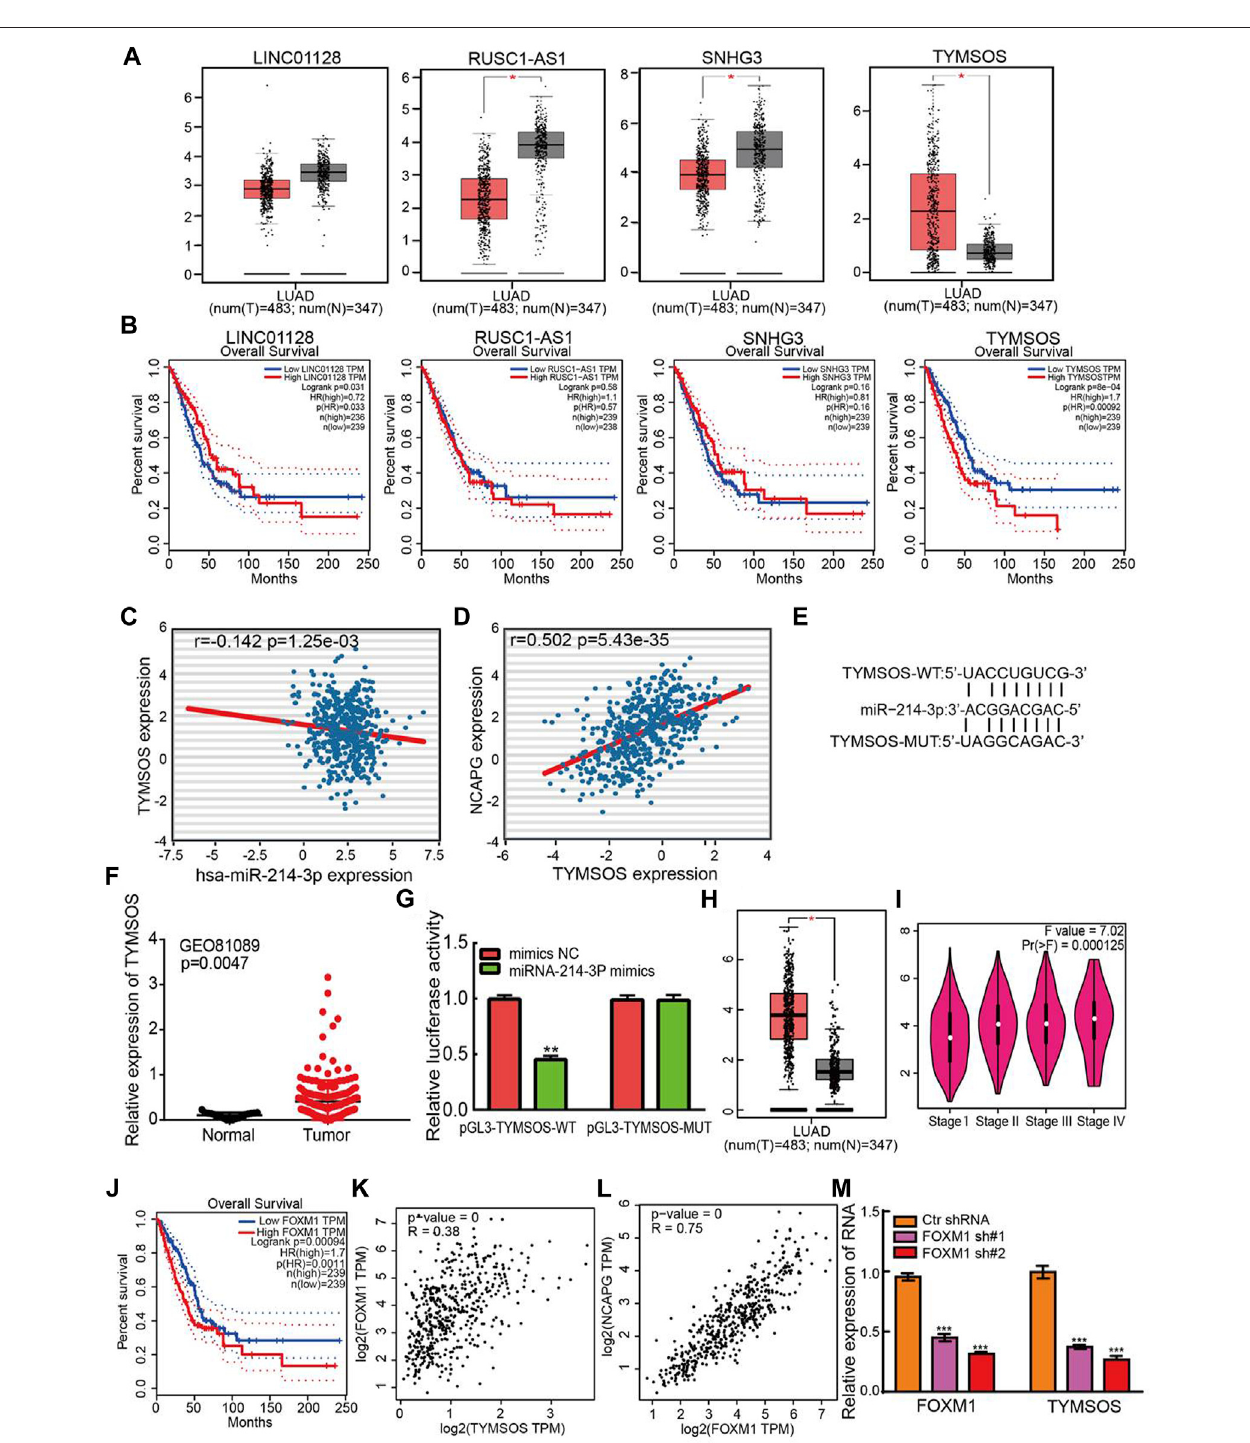
FIGURE 11 | Identi fi cation of upstream lncRNAs of miRNA-214-3p in LUAD. (A) The expression of LINC01228, RUSC1-AS1, SNHG3, and TYMSOS in TCGA- LUAD. (B) The prognostic values of LINC01228, RUSC1-AS1, SNHG3, and TYMSOS in TCGA-LUAD. (C) The correlation between expression of miRNA-214-3p and TYMSOS in LUAD. (D) The correlation between expression of NCAPG and TYMSOS in LUAD. (E) The potential binding sites of miR-214-3p and TYMSOS. (F) The expression of TYMSOS in GSE81089 and control normal samples determined by GEO database. (G) Relative luciferase activities of wild-type (WT) and mutated (MUT) THTMSOS reporter plasmid in A549 cells cotransfected with miRNA-214-3p mimics. (H) The expression of FOXM1 in LUAD was examined by using the GEPIA database. (I) The pathological stage analysis for FOXM1 in LUAD was determined by the GEPIA database. (J) The overall survival analysis for FOXM1 in LUAD was examined by using the GEPIA database. (K) The correlation between expression of FOXM1 and TYMSOS in TCGA-LUAD. (L) The correlation between expression of FOXM1andNCAPGinTCGA-LUAD. (M) TYMSOSexpressioninA549cellafterknockdownFOXM1wasexaminedbyreal-timePCR.* p < 0.05,** p < 0.01,*** p < 0.001.